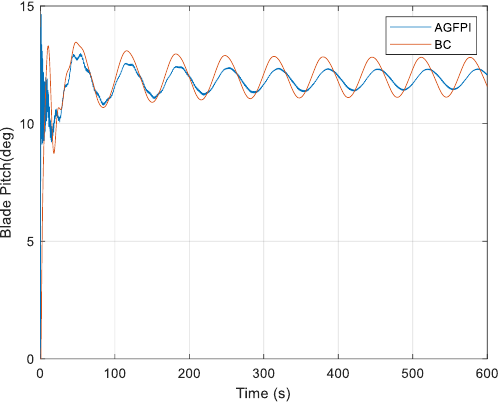
Figure 4. Pitch angle control without waves.